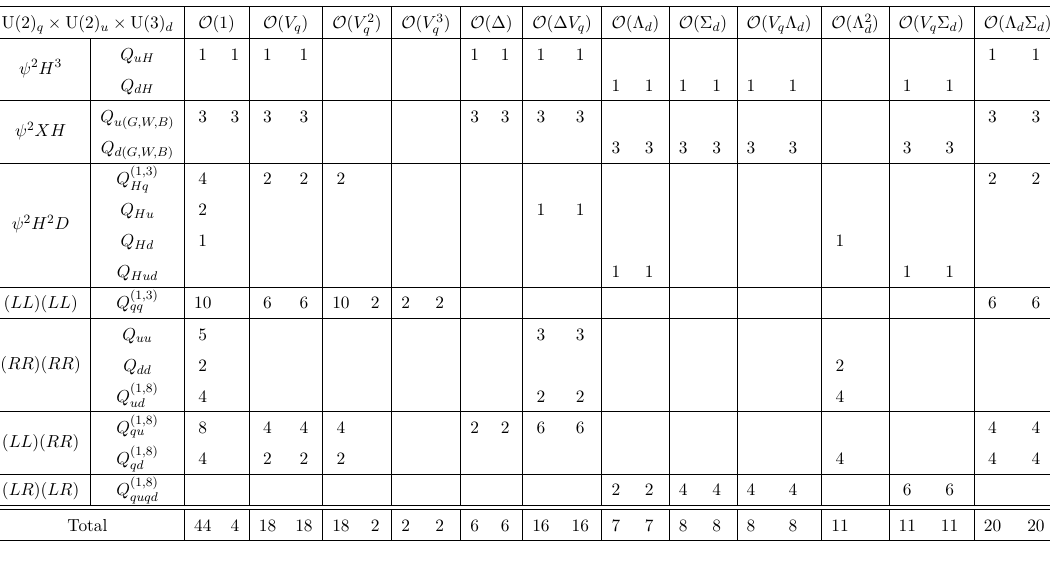
Table 5 . Counting of the pure quark SMEFT operators (see appendix A) assuming U(2) q × U(2) u × U(3) d symmetry in the quark sector. The counting is performed taking up to three insertions of V q , one insertion of ∆ u or Σ d , and two insertions of Λ d as well as one insertion of ∆ u V q , V q Λ d , V q Σ d , and Λ d Σ d products each. The left (right) entry in each column gives the number of CP even (odd) coefficients at the given order in spurion